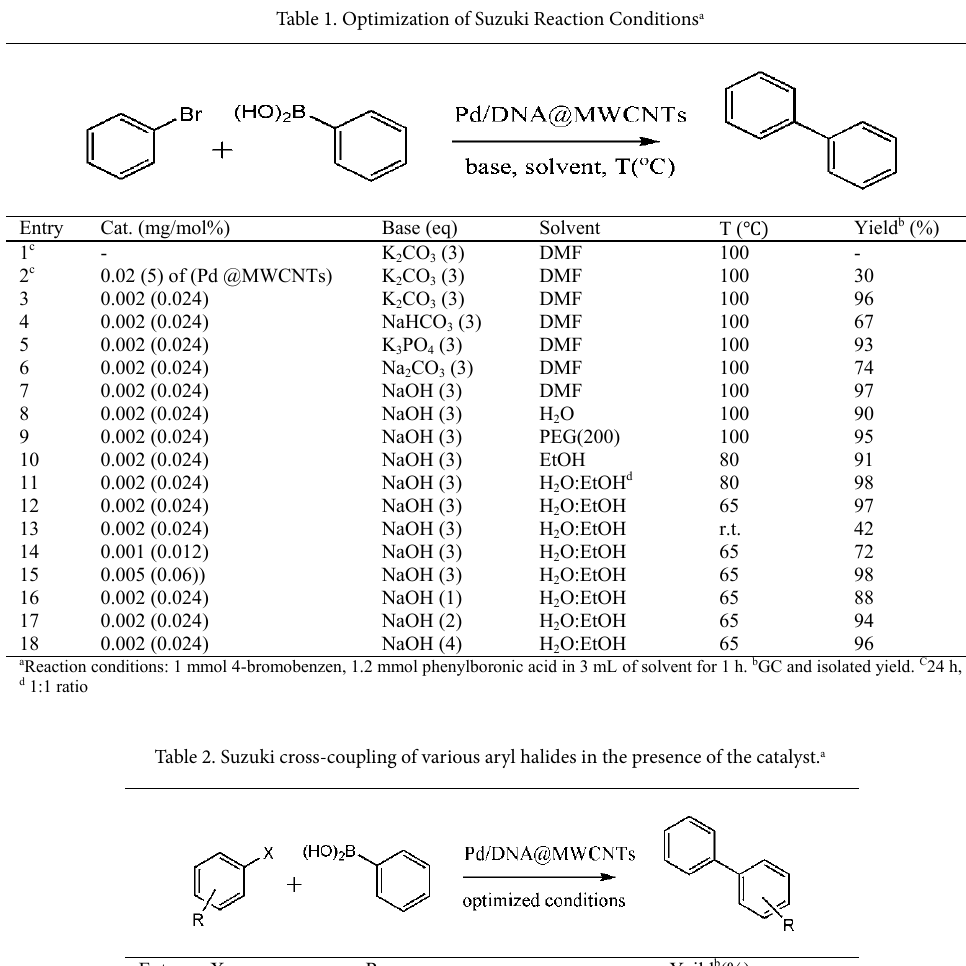
Table 1. Optimization of Suzuki Reaction Conditions a